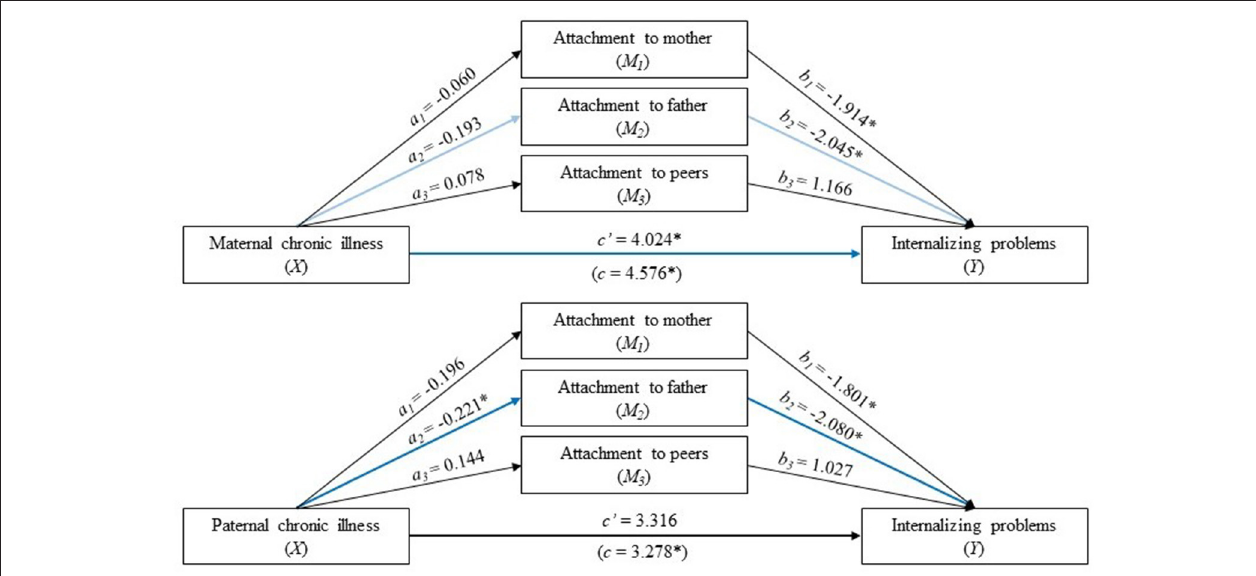
FIGURE 3 | Separate analyses for adolescent females. Parallel mediation analysis with parental (maternal above and paternal below) chronic illness status (0 is no and 1 is yes) as the independent variable (X), internalizing problems in young adulthood with a high score indicates high levels of problems (Y), and attachment to the mother, father, and peers as the mediators (a high score indicates secure attachment). The values are unstandardized regression coefficients. a n is the effect of parental chronic illness in adolescence on attachment to the mother, father, and peers; b n is the effect of attachment to the mother, father, and peers on internalizing problems in young adulthood. The analysis was adjusted for adolescent sex and parental SES and divorce. The blue lines show a statistically significant path (light blue indicates borderline significance). * p < 0.05, ** p < 0.01, *** p < 0.001.